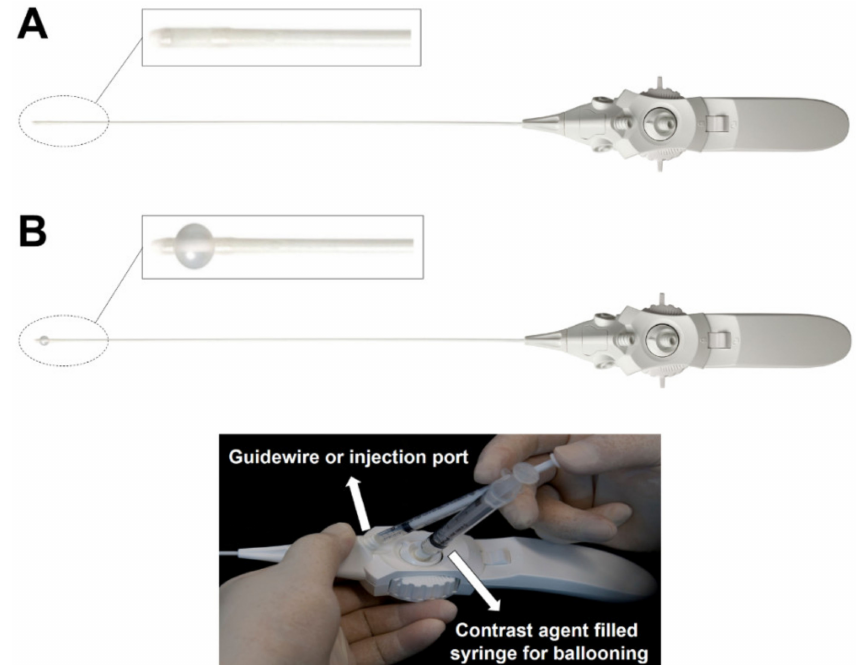
Figure 1. An inflatable balloon catheter (ZiNeu ® , JUVENUI, Seoul, Korea). An elastic inflatable balloon is attached to the end of the catheter tip. The balloon can be inflated with about 0.13 mL of contrast dye. ( A ) A deflated state of balloon at the tip of the catheter. ( B ) An inflated state of balloon at the tip of the